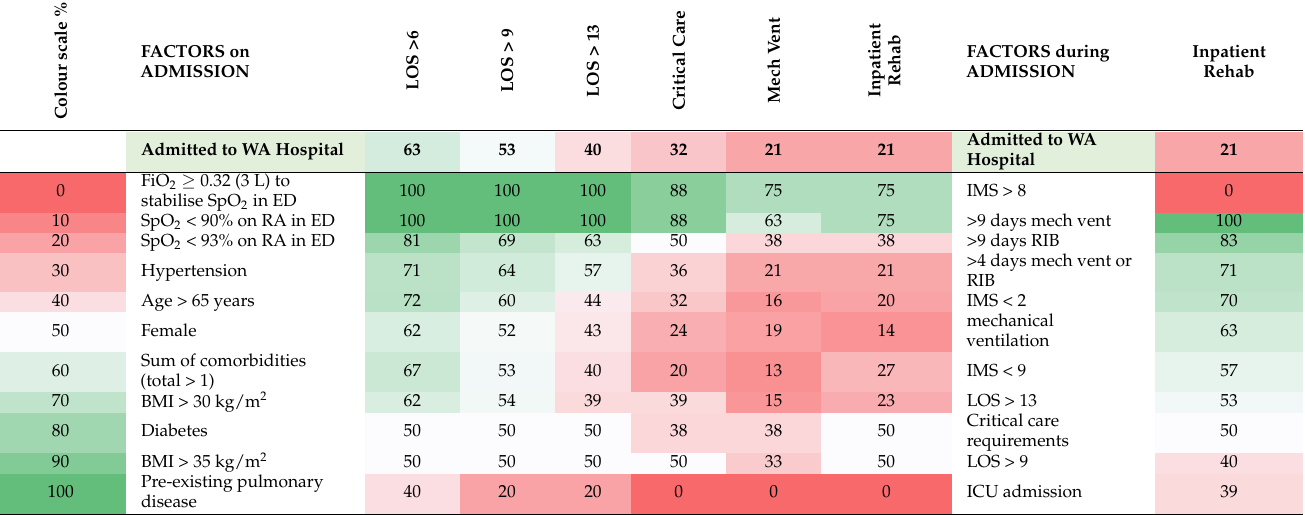
Table 3. Characteristics * of COVID+ patient by length of stay, critical care, mechanical ventilation and